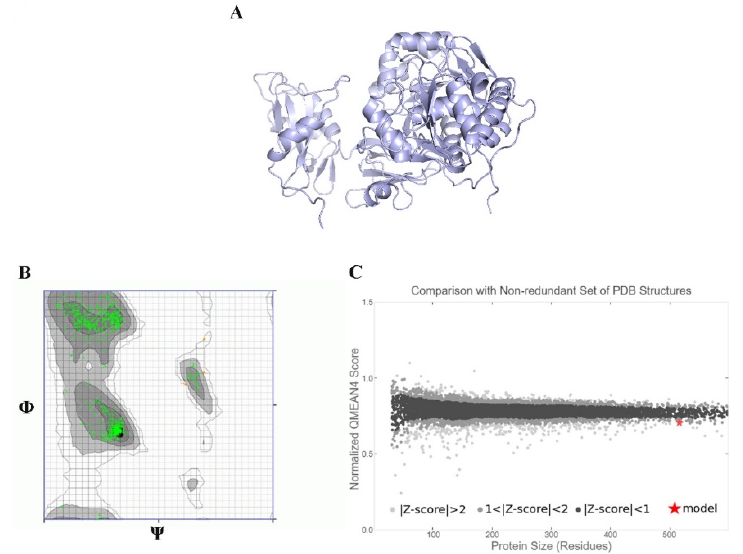
Figure 9. Matrix protein model: ( A ) ribbon view of matrix protein model, ( B ) Ramachandran plot, and ( C ) qmean Z-score plot.